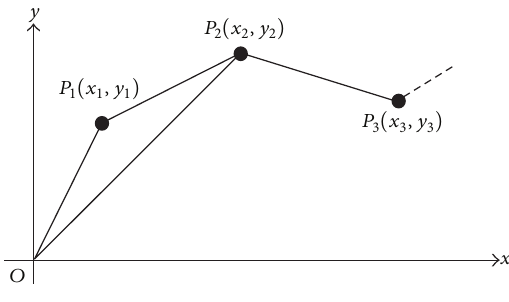
Figure 5: Piecewise linear